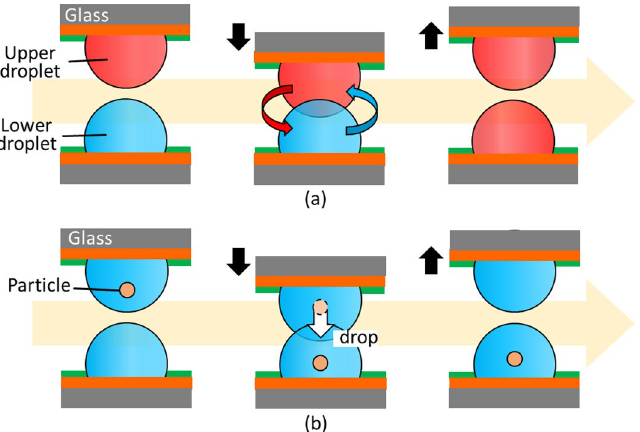
Figure 1. Contact and transport between droplet pairs by droplet-array sandwiching technology. One droplet pair is depicted for explanation. Droplets are generated and prepared on different substrates with hydrophilic– hydrophobic patterns. The two substrates are arranged facing each other by aligning corresponding droplet pairs in the vertical direction. The corresponding droplets come into contact and fuse when opposing substrates are moved closer together. ( a ) Illustration of a mixture of two droplets for concentration control of substances. Substances in the upper droplet diffuse into the lower droplet through the fused contact part and mix in the fused droplet pair. ( b ) Illustration of particle transport between droplet pairs. Particles in the upper droplet move into the lower